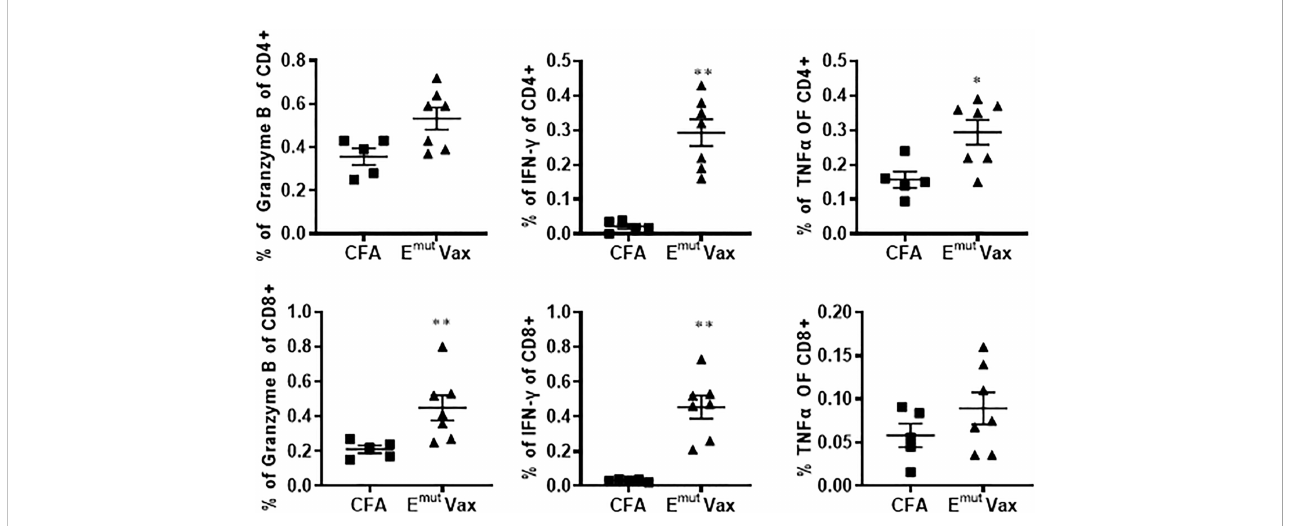
FIGURE 3 E mut Vax increased Th1 immune responses in a tumor-bearing syngraft model. Spleens were harvested from mice in the UN680 Del19 syngraft model, restimulated with E mut multi-peptides, and frequencies of Th1 cytokine and cytolytic granule-producing CD4+ and CD8+ were analyzed. Data are shown as the mean ± SE of three replicate samples per group, n=5 in ADJ and n=7 in E mut VAX, *P ≤ 0.05, **P ≤ 0.01 vs ADJ